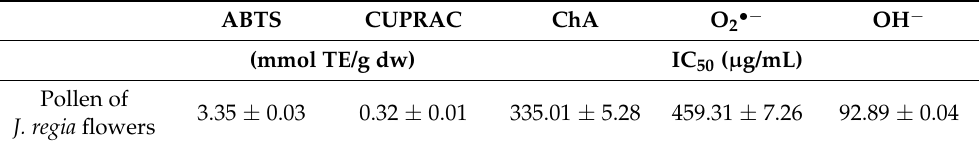
Table 2. Antioxidant activities of J. regia pollen extract. ABTS CUPRAC ChA O 2 •− OH − (mmol TE/g dw) IC 50 ( µ g/mL) Pollen